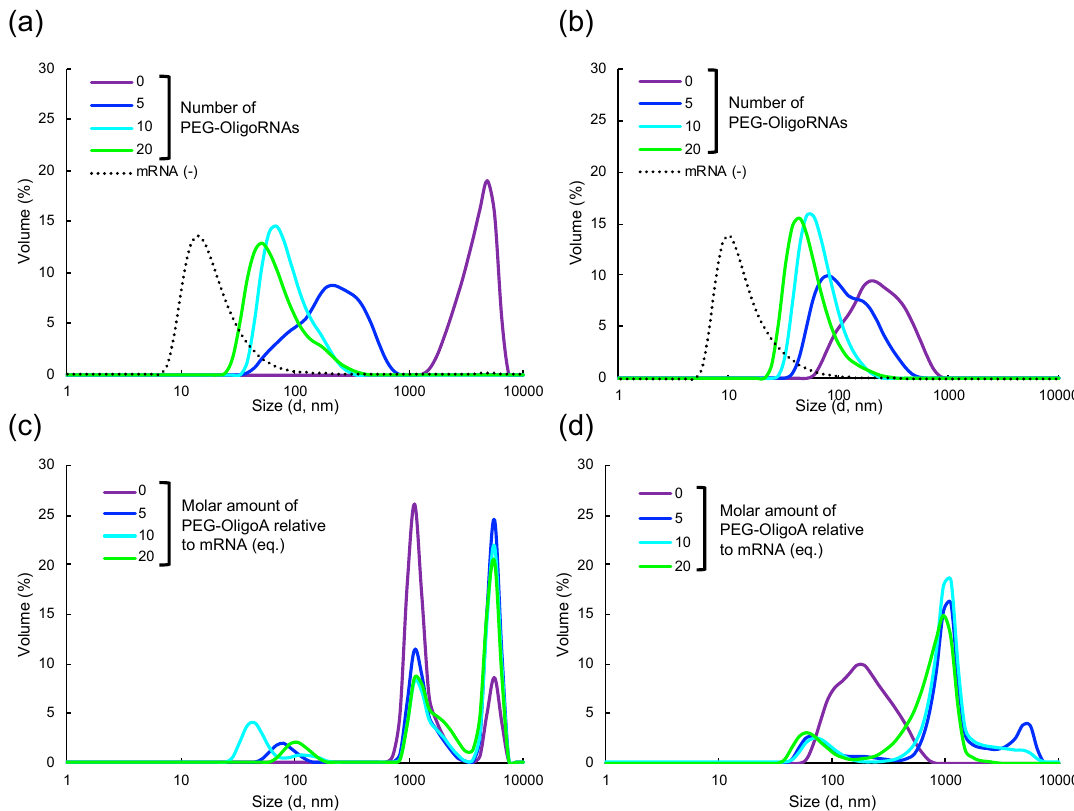
Figure 3. Dynamic light scattering measurement of Lipofectamine LTX/mRNA LNPs. Two LNP formulations were prepared by mixing mRNA with ( a , c ) minimal or ( b , d ) maximal volume of lipofectamine LTX solution that the manufactures suggest to use (( a , c ) Lipo-Min and ( b , d ) Lipo-Max). ( a , b ) The size of the LNP without mRNA addition (mRNA ( − )), and that loading mRNA hybridized with 0, 5, 10, or 20 PEG-OligoRNAs was measured. ( c , d ) PEG-OligoA was used as a control PEG-OligoRNA that does not hybridize to mRNA. 5 eq., 10 eq., and 20 eq. of PEG-OligoA relative to mRNA was added to mRNA for preparation of Lipo-Min and Lipo-Max.